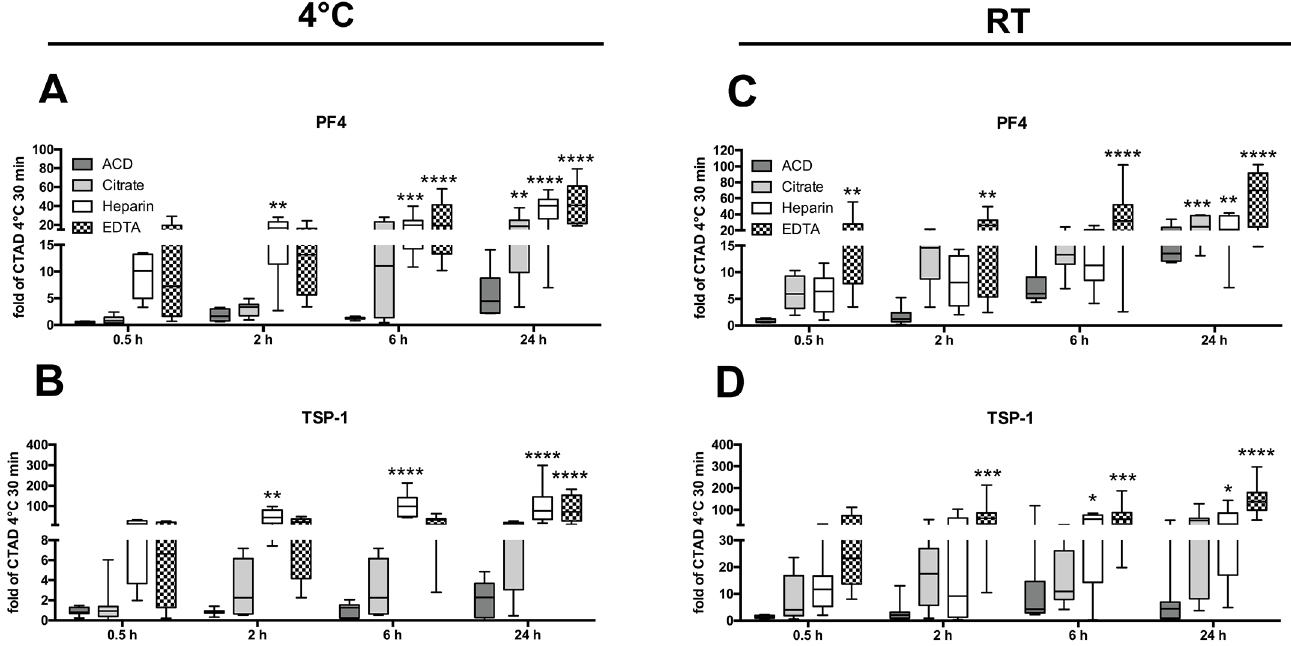
Fig 4. Fold-increase of platelet-stored factors due to suboptimal plasma generation. Plasma concentrations of PF4 (A, C) and TSP-1 (B, D) were calculatedas fold of plasma levels relativeto CTAD plasma 30 min 4˚C (8 healthy donors).Fold-increaseis depicted for ACD (dark grey bar), citrate (grey bar), heparin(white bar) or EDTA (patternedbar) plasma at 0.5 h, 2 h, 6 h, and 24 h. Samples were either processedat 4˚C (A-B) or at ambient temperature (C-D). Significantdifferences were analyzedusing one-wayANOVA with Dunnett correction and were depictedas * p < 0.05, ** p < 0.01, *** p < 0.001, and **** p < 0.0001 (in comparisonto CTAD 30 min